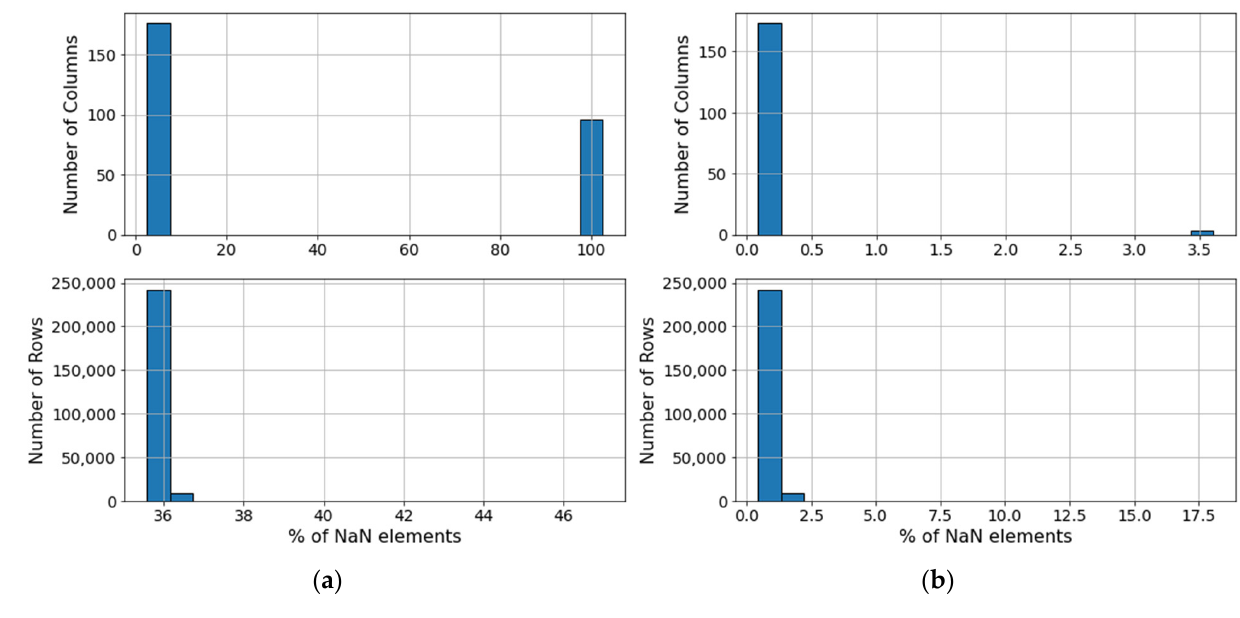
Figure 6. Distribution of NaN entries in recorded sensor data: ( a ) original distribution; ( b ) processed distribution. Table 3. Dataset reduction by void entry